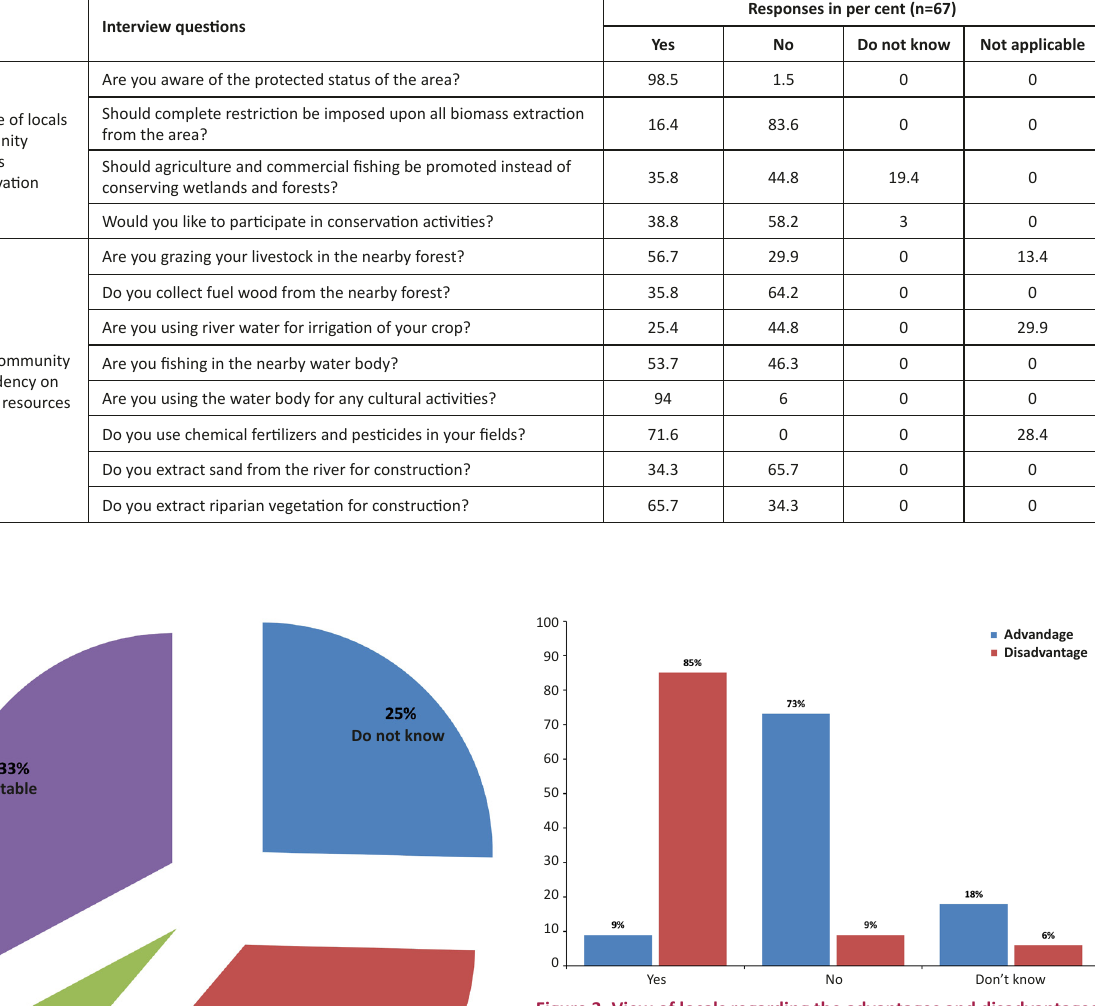
Table 1. Attitude of local riparian community toward conservation and their dependency on the natural resources. Interview questions